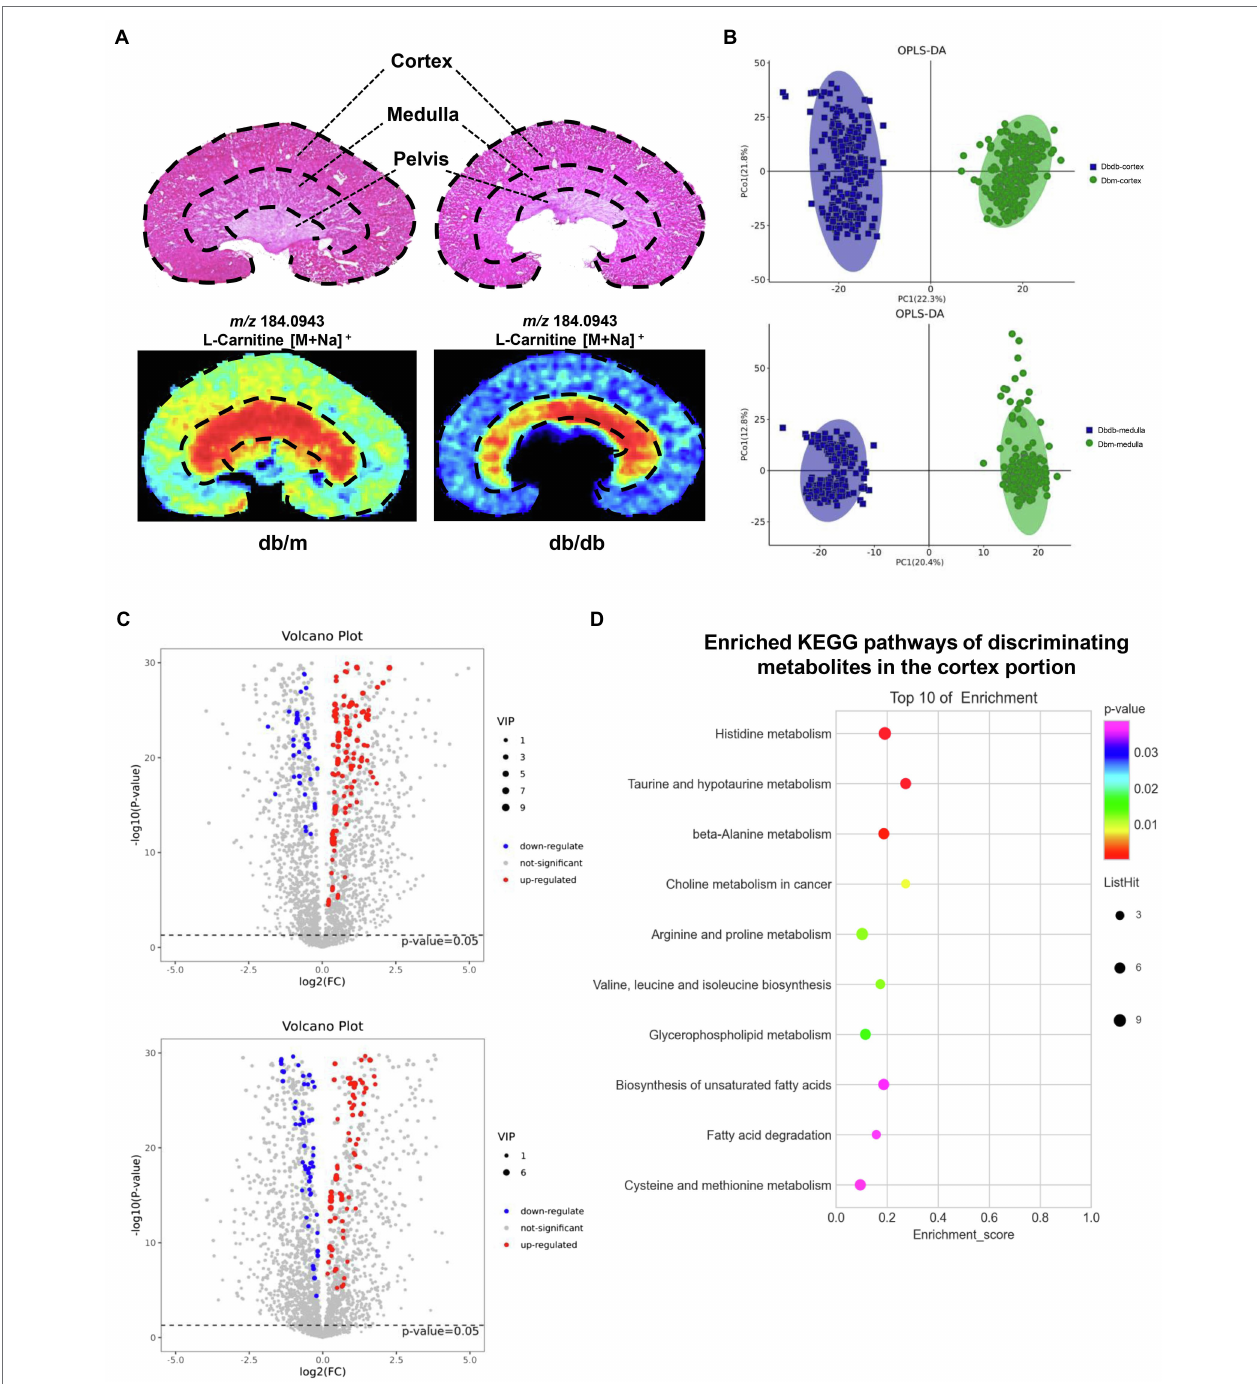
FIGURE 3 | AFADESI–MSI analysis between kidneys of db/m ( n = 2) and db/db mice ( n = 2). (A) H&E staining with the structure diagram of mice kidney (upper) and MSI of a representative metabolite(l-carnitine) in db/m and db/db kidney are shown. (B) OPLS–DA plots of the metabolites detected in MSI negative ion mode in the cortex (upper) and medulla (down) for kidneys of db/m and db/db mice. (C) Volcano plots showing the discriminating metabolites in the cortex (upper) and medulla (down) of db/db vs. db/m mice in negative ion mode. (D) The bubble plot showing the enriched KEGG pathways of discriminating metabolites in the cortex portion between the kidneys of db/db and db/m